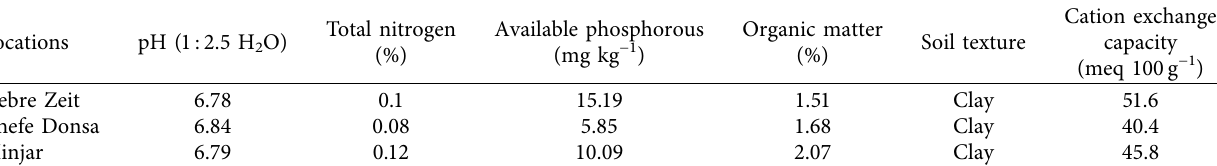
Table 2: Presowing soil physicochemical properties of experimental